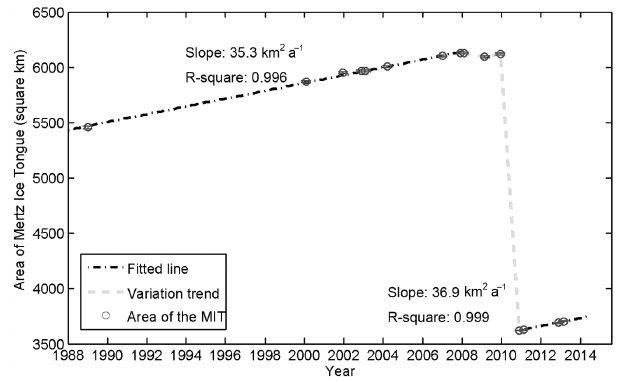
Figure 8. Average trend of the area change of the MIT. The area of the MIT is extracted from the Landsat images from 1988 to